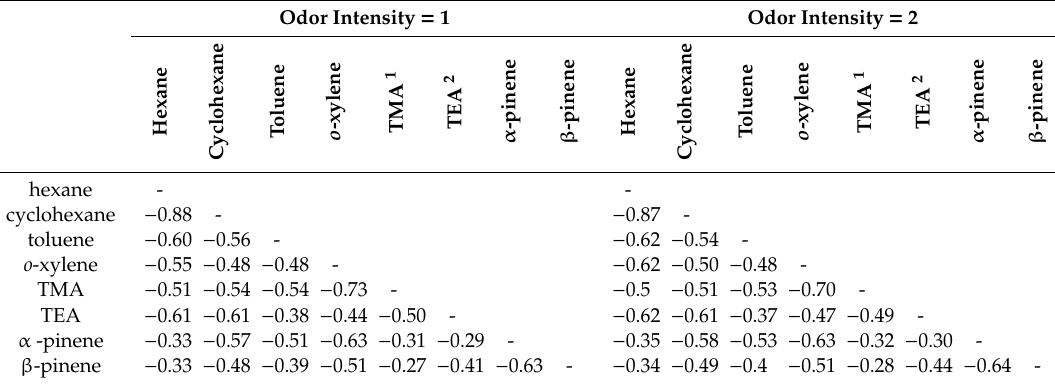
Table 6. Vectorial additivity odor interaction coe ffi